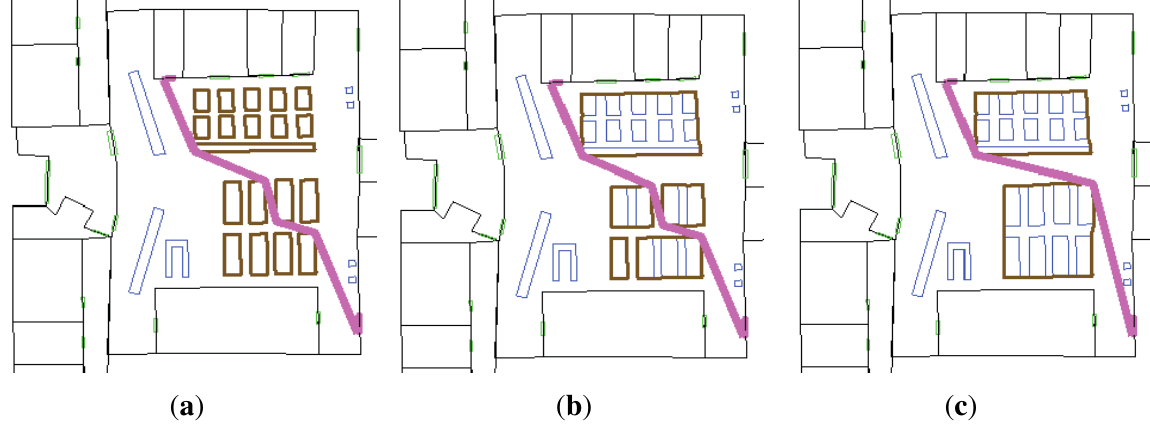
Figure 16. The shortest paths for the sizes 0.5 m, 0.8 m and 1.0 m on the floor plan of the campus building. ( a ) Path for the 0.5 m size; ( b ) path for the 0.8 m size; ( c ) path for the 1.0 m